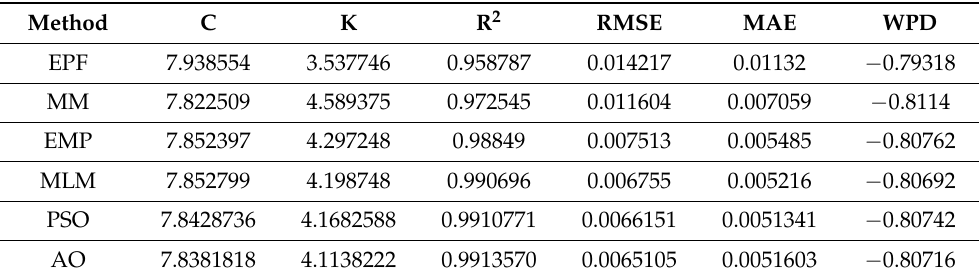
Table 3. Statistical analysis: Zafarana site, 2019 [34].